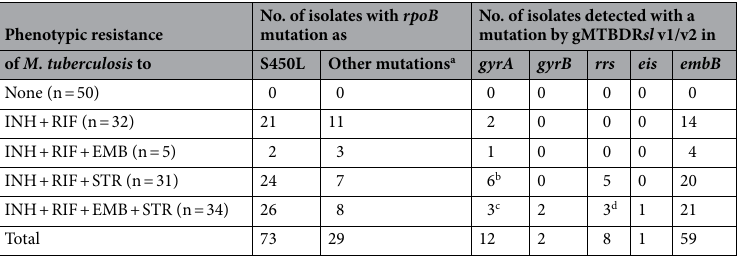
Phenotypic DST patterns. The drug-susceptible M. tuberculosis isolates (n = 50) were susceptible to all 4 SIRE (streptomycin or STR, INH, RIF and EMB) drugs tested (pansusceptible strains). When MDR-TB strains were tested, 32 isolates were resistant to 2 (INH + RIF) drugs, 36 isolates were resistant to 3 (INH + RIF + STR = 31 and INH + RIF + EMB = 5) drugs and 34 isolates were resistant to all 4 SIRE drugs (Table 2). The GenoType MTBDR plus assay/PCR-sequenc- ing data showed that all pansusceptible strains (n = 50) were susceptible to RIF (Table 2) and INH as they yielded wild-type patterns for rpoB, katG and inhA . All MDR-TB strains were resistant to RIF based on GenoType MTBDR plus assay/PCR-sequencing data as they exhibited an rpoB mutation. Of 102 MDR-TB strains, 73 and 3 isolates contained S450L and S450W mutation, respectively, while 26 isolates contained mutations at other rpoB codon positions (Table 2). However, GenoType MTBDR plus assay/PCR-sequencing data confirmed the MDR- TB status of only 100 isolates as 2 isolates exhibited wild-type pattern for katG and inhA suggesting that INH resistance in these 2 isolates either involved mutations in other regions of katG or inhA genes or in other genes 3 . Genotypic detection of resistance to FQs and SLIDs. All 50 pansusceptible M. tuberculosis isolates contained wild-type pattern for gyrA , rrs and embB codon 306 by gMTBDR sl v1 assay and for gyrA , gyrB , rrs and eis genes by gMTBDR sl v2 assay (Table 2). When 102 MDR-TB strains were tested by gMTBDR sl v1 and